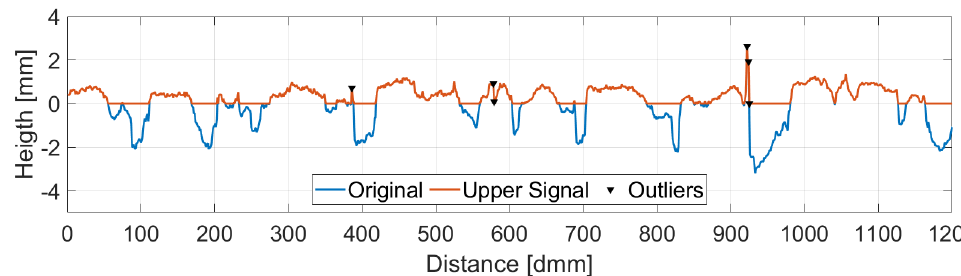
Figure 4. Outlier Detection. Upper Part vs. Original